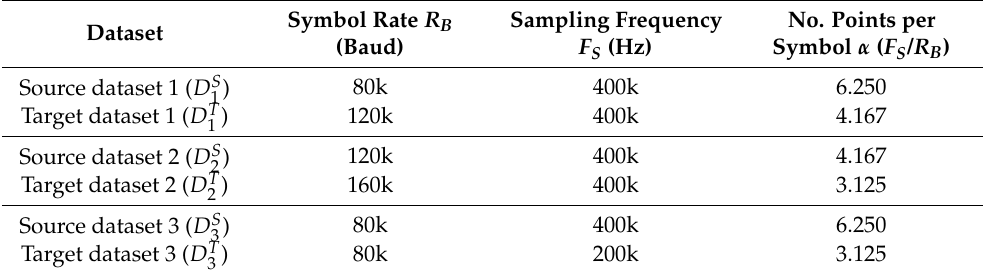
Table 3. Symbol rate and sampling frequency settings of different source and target datasets.